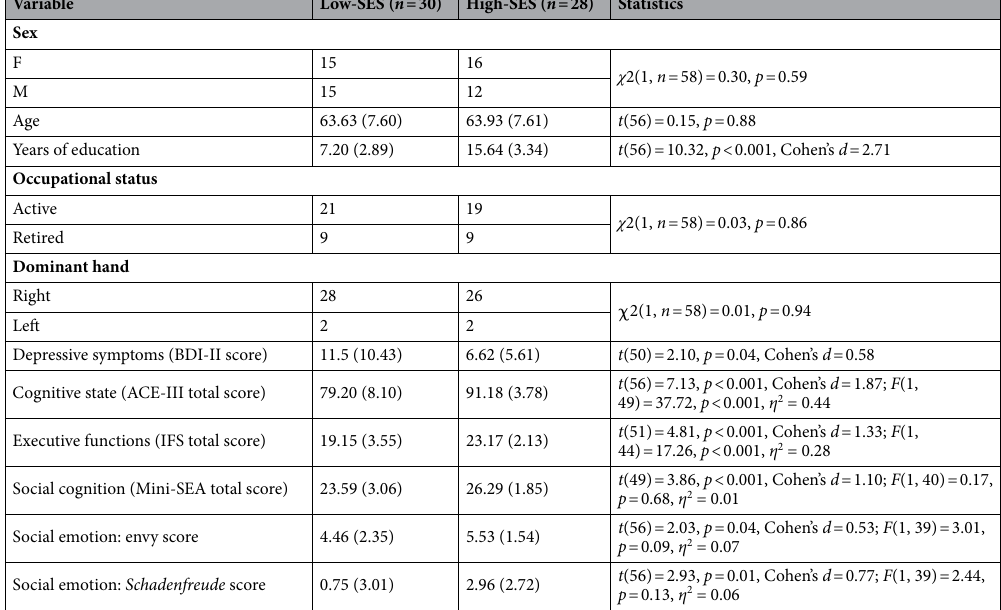
off: 86), with higher scores indicating better performance. The ACE-III has proved useful in detecting cognitive impairment in healthy older adults 42 . Executive functions. Executive functions were assessed with the INECO Frontal Screening (IFS) 43 , a brief screening tool that taps three executive functions: response inhibition and set shifting, working memory, and abstraction capacity. The IFS total score ranges from 0 to 30, with higher scores indicating better executive per- formance. The IFS has good sensitivity to evaluate frontal-executive dysfunction in older adults 44 . Social cognition. The Mini-Social Cognition and Emotional Assessment (Mini-SEA) 45 was used to asses two social cognition domains: facial emotion recognition and ToM. In the facial emotion recognition subtest, par- ticipants are required to select the emotion being expressed by an individual’s face among the following options: sadness, disgust, anger, fear, happiness, surprise, or neutral. In total, 35 items are displayed, giving 1 point for each correct response. ToM is evaluated by the Faux Pas subtest, in which short stories are presented to partici- pants, who must detect social transgressions and infer the feelings and intentions of the stories’ characters. It consists of 10 items, and the total score ranges from 0 to 40. To obtain the overall Mini-SEA score, both facial emotion recognition and Faux Pas total scores are converted to a score out of 15 and then summed, ranging from 0 to 30, with higher scores indicating better performance. This test has been previously employed to evaluate social cognition among older adults 46,47 . Social emotions. Envy and Schadenfreude were assessed through an experimental paradigm based on Taka- hashi et al. 34 , adapted to Spanish language and validated in Latin American populations 48–53 . The task consists of the presentation of 40 fictional situations designed to evoke unpleasant (envy, e.g., ‘He won the lottery and he is a millionaire’, n = 15) or pleasant ( Schadenfreude , e.g., ‘He was excluded from his friends’ group because he is a liar’, n = 15) emotions, as well as emotionally neutral (e.g., ‘He turned off the light’) situations included separately for envy ( n = 5) and Schadenfreude ( n = 5). First, participants are presented with a real-life photograph and a description of two characters matched to the participant in terms of age and sex. Subsequently, the situations for each type of emotion are described involving the characters individually. Envy- and Schadenfreude -eliciting situ- ations are presented in two different blocks (envy first), alternating with the corresponding neutral situations. In both blocks, after reading each situation, participants are asked to report the intensity of their ‘displeasure’ (for the envy block) or ‘pleasure’ (for the Schadenfreude block) on a 1 (low emotional intensity) to 9 (high emotional intensity) Likert scale. To control for basic understanding of the task structure, weighted variables for envy and Schadenfreude are computed by subtracting the neutral scenarios’ score to each emotion’s score. Hereafter, envy weighted and Schadenfreude weighted variables are referred as envy and Schadenfreude, respectively.